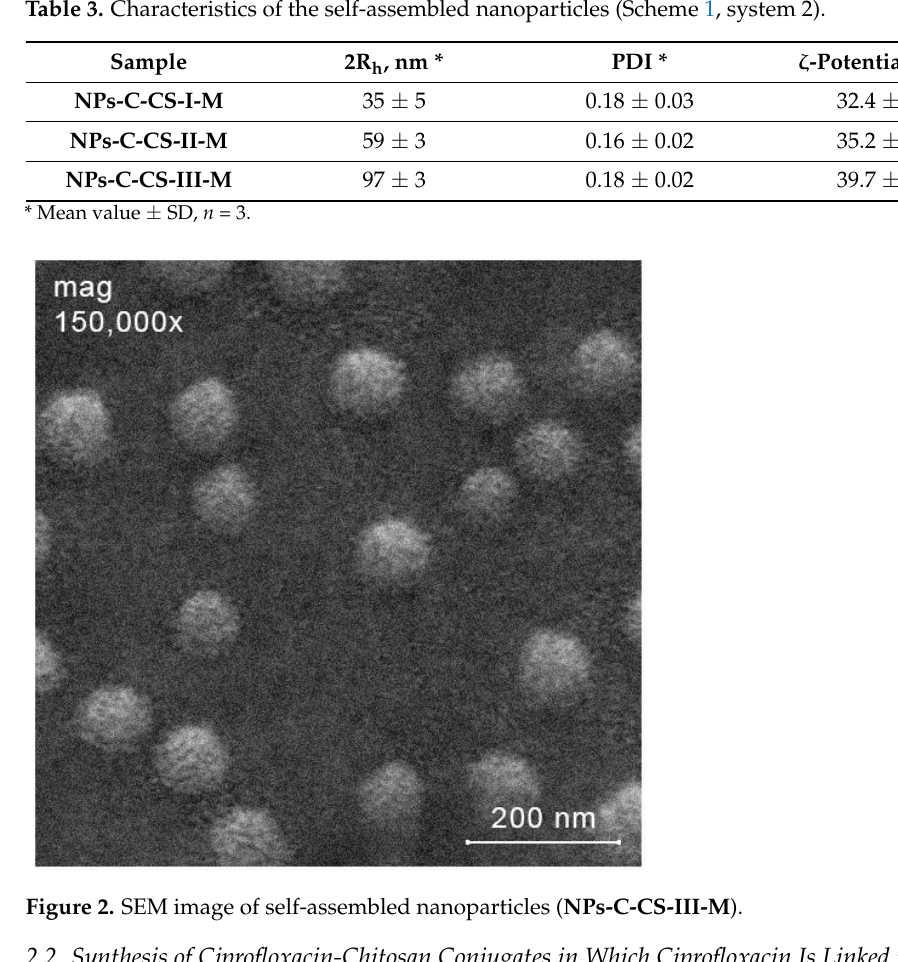
Figure 2. SEM image of self-assembled nanoparticles ( NPs-C-CS-III-M